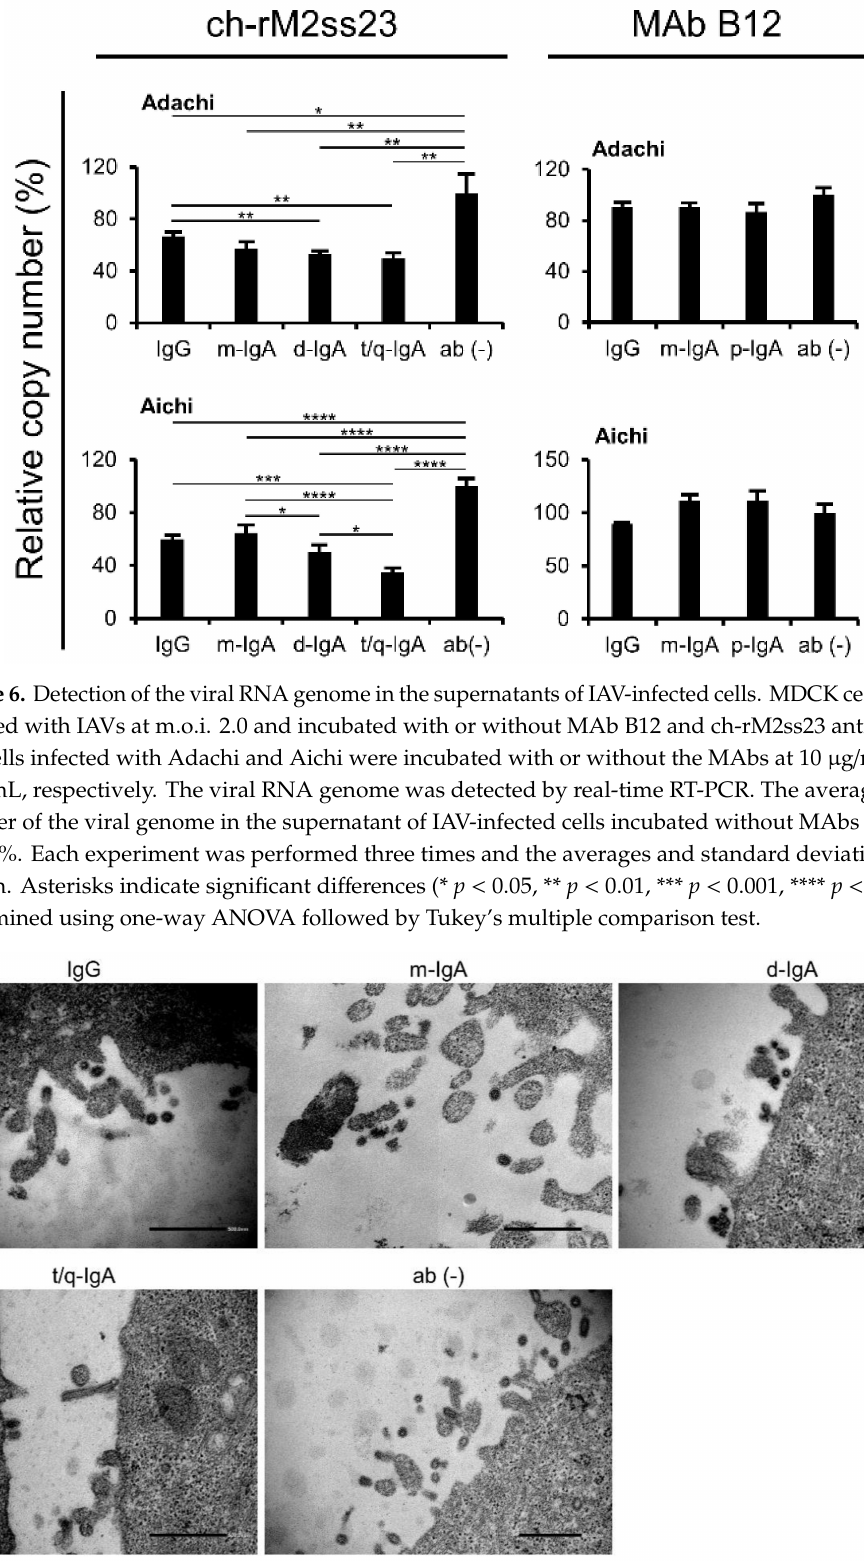
Figure 7. Electron microscopy of virus particles on the surface of Aichi-infected cells. MDCK cells were infected with Aichi at m.o.i. of 2.0 and incubated for eight hours with or without ch-rM2ss23 IgG, m-IgA, d-IgA, and t / q-IgA. Scale bars represent 500